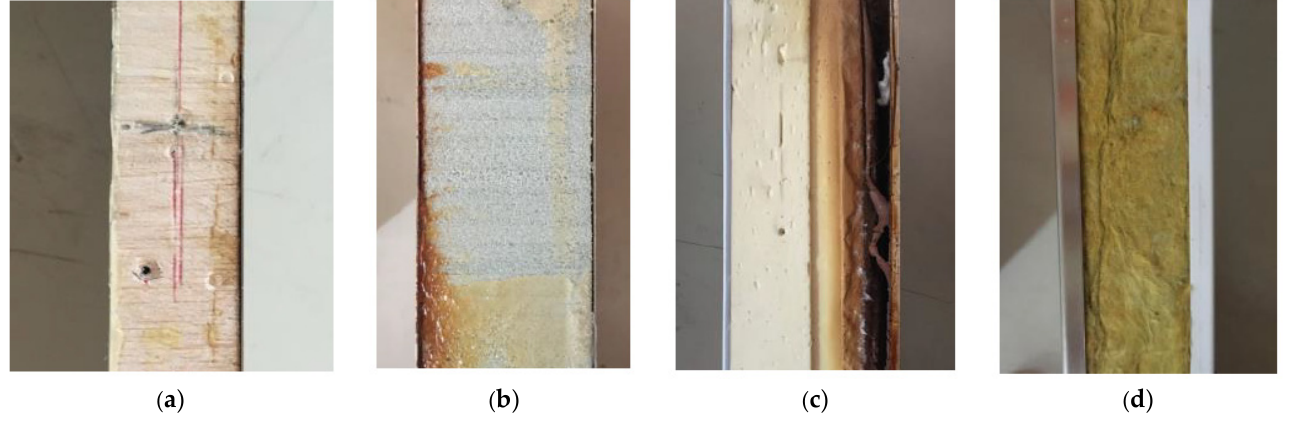
Figure 9. Photos of each type of material and its condition after being tested: ( a ) BAL; ( b ) PET; ( c ) PUR; ( d ) MW.